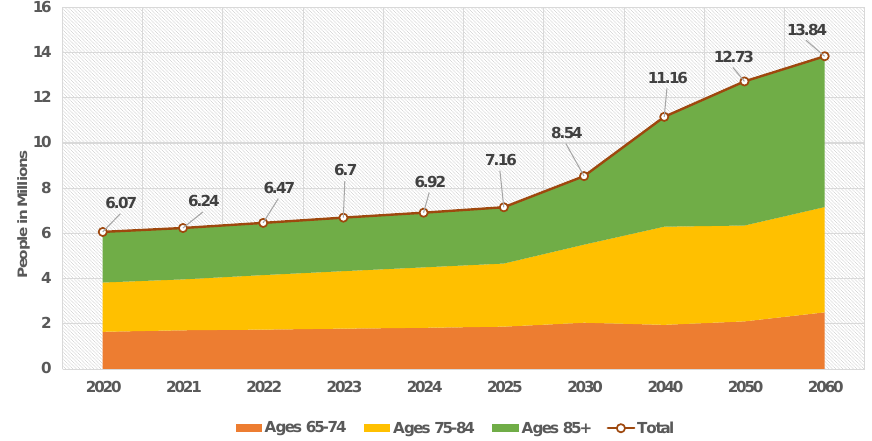
Figure 1. The anticipated number of US people above 65 with AD from 2020 to